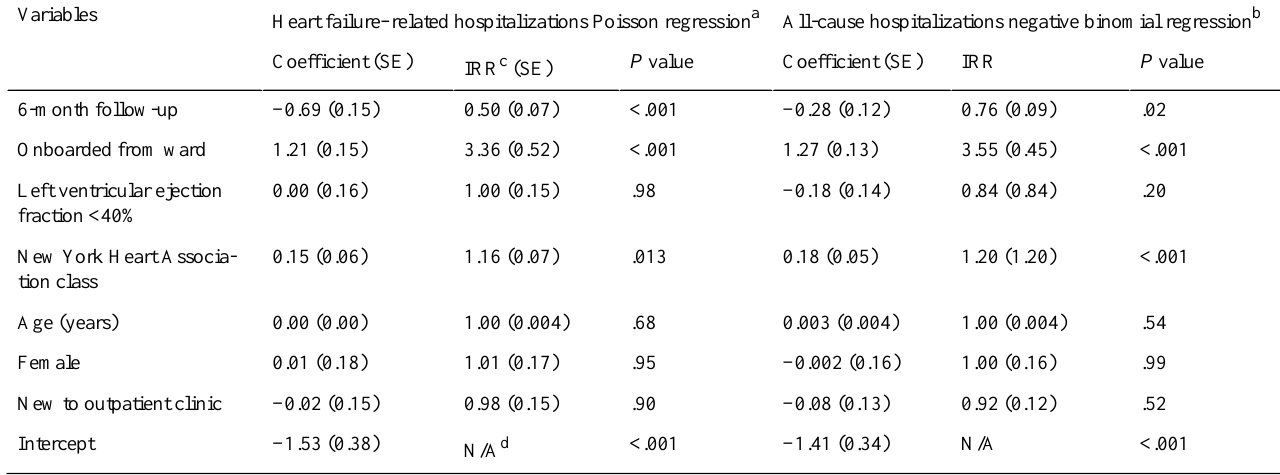
Table 2. Poisson and negative binomial regressions showing the effect of 6 months in the Medly program on the number of heart failure–related and all-cause hospitalizations when controlled for key demographic and clinical variables.